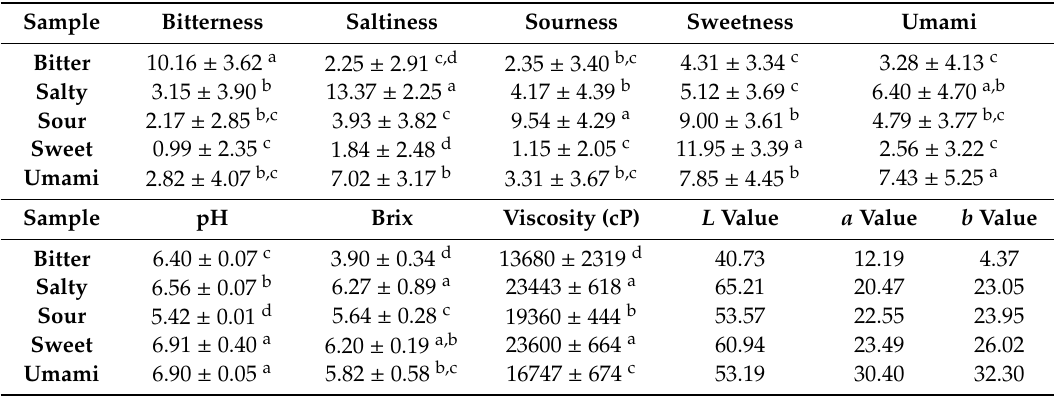
Table 1. Mean and standard deviation values of the sensory, chemical, and color data of the chocolate samples used for this